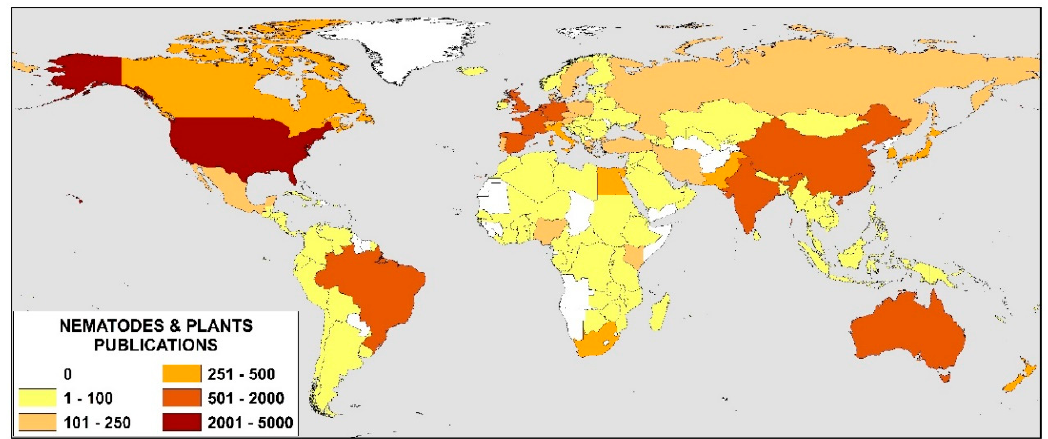
Figure 2. World map of the countries with the highest number of publications in the period 1950–2019.